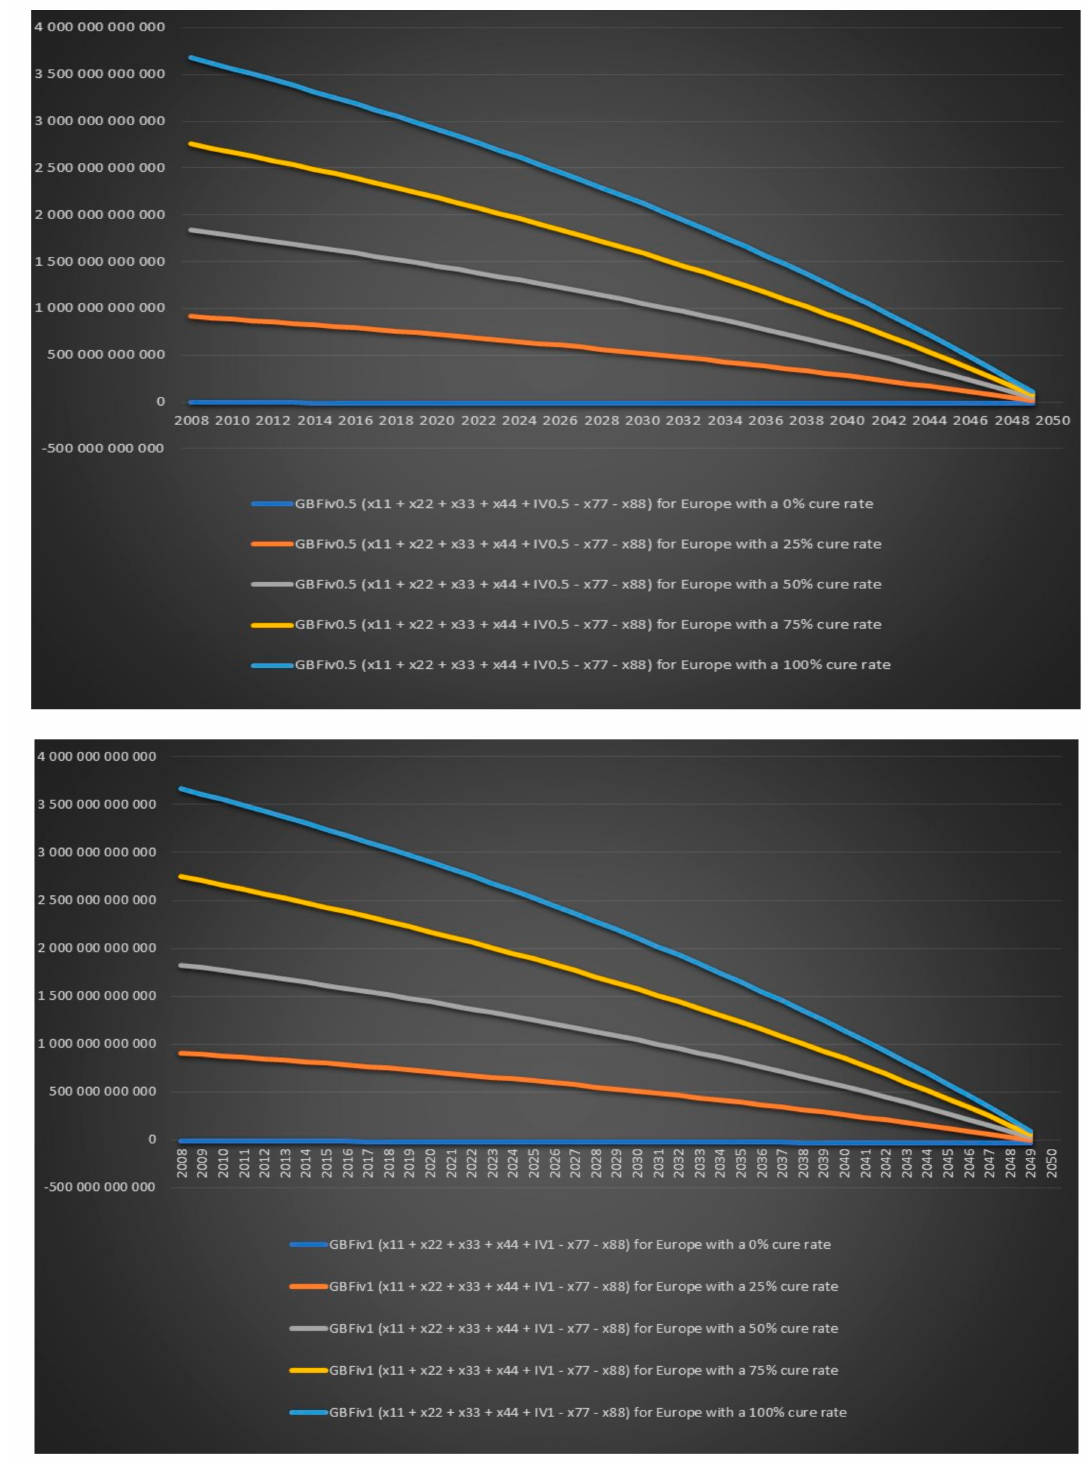
Figure 22. Future government costs and revenues in Europe over